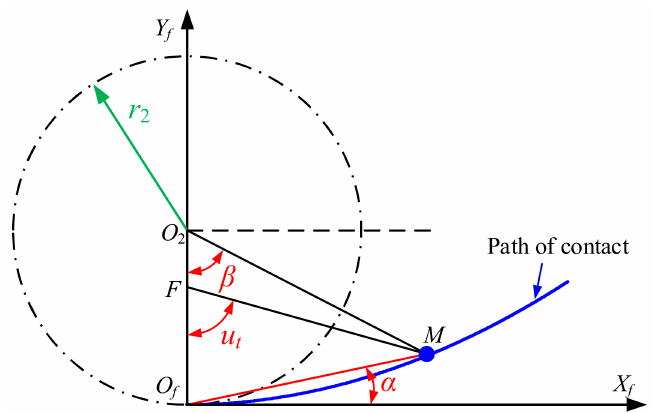
Figure 4. Parabolic path of contact at the first